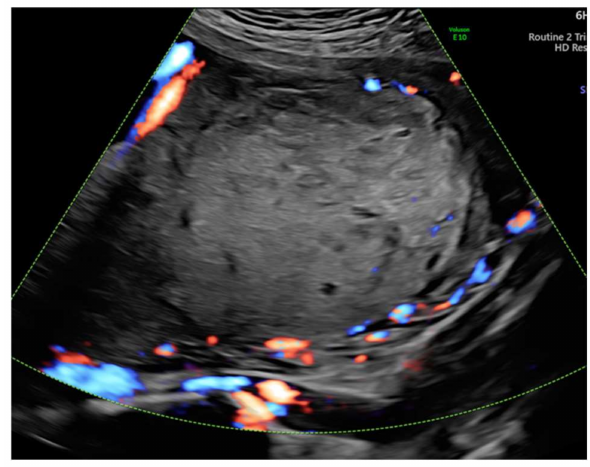
Figure 4. Doppler showed normal vascularization at 30 weeks of gestation.